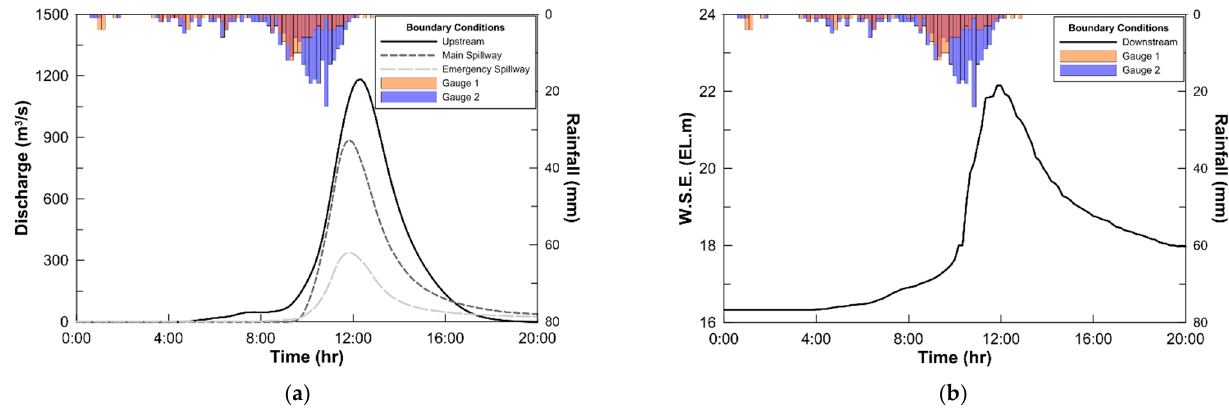
Figure 6. Boundary conditions for verification. ( a ) Upstream discharge and dam outflow; ( b ) Downstream water level.